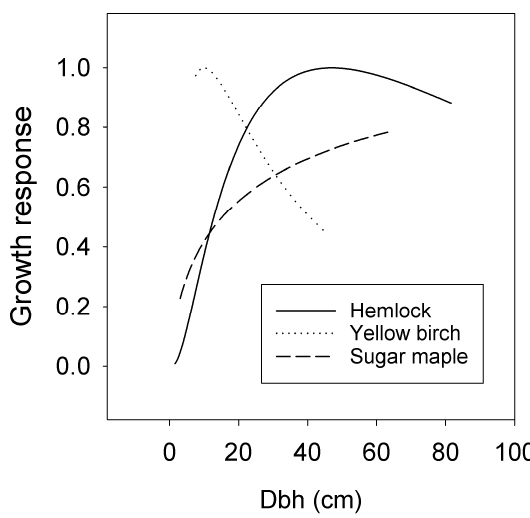
Figure 2. Influence of tree size (dbh) on predicted radial growth rate (fraction of potential growth) of three tree species in an old-growth hemlock stand on the Helderberg plateau in east–central New York. Deciduous species were more e ff ective than evergreens at suppressing the growth of competitors, regardless of the competing species identity, as indicated by the competitive e ff ect coe ffi cient λ which was consistently larger for deciduous species than for evergreen species (Table 3). Competition